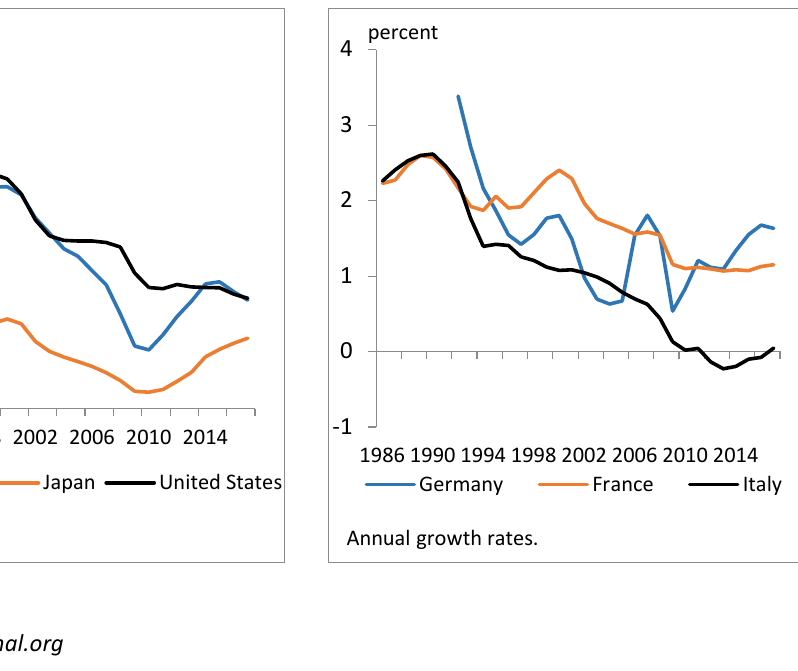
Figure 2 : Potential output growth in advanced